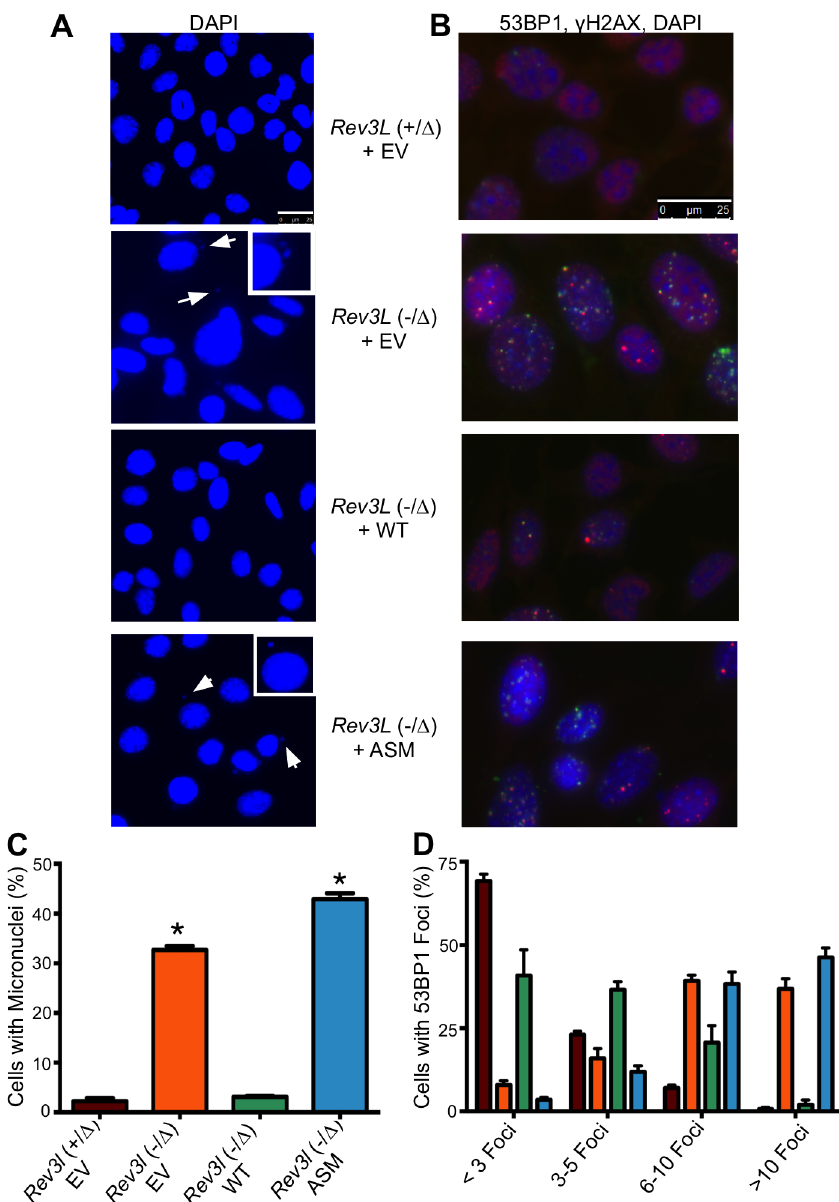
Fig 2. Spontaneous DNA double-strand break formation is reduced in Rev3l complemented MEFs. (A) DAPI staining of empty vector (EV)-expressing Rev3l +/ Δ , Rev3l -/ Δ , as well as Rev3l -/ Δ MEFs expressing wild- type or ASM recombinant REV3L ; arrows indicate micronuclei, with an enlarged example in the inset. (B) Merged immunofluorescence staining of the same MEFs as in (A) with DAPI (blue), 53BP1 (red) and γ -H2AX (green); foci indicate areas of DNA double-strand breaks. (C) Quantification of percent of nuclei that have associated micronuclei. (D) Quantification of cells with fewer than 3, 3 to 5, 6 to 10 or greater than 10 53BP1 foci (as measured using CellProfiler). The bars are color-coded exactly as in Part C to indicate the genotype of the MEFs ( * ) p < 0.01. Data represent mean ± SEM.